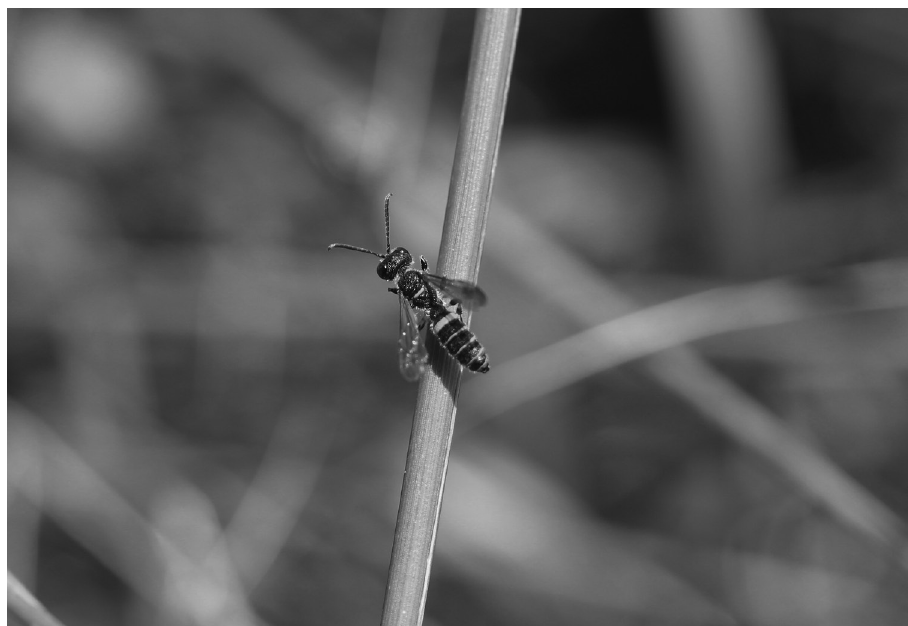
Figure 1. A male of C. clypeata on his perch, a grass stem, at the site where he dragged his abdomen in the farm